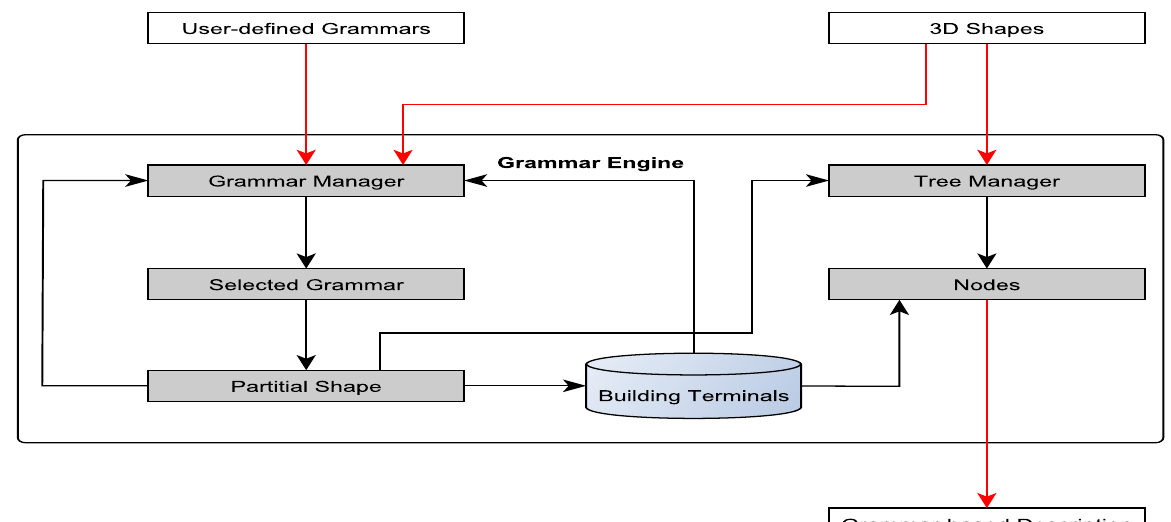
Figure 6: The main flow for proposed grammar engine is given. The block diagrams in grey indicate internal modules, and connection between internal modules uses black lines. The external module is in white block diagram and uses red lines to connect with internal modules. The blue block diagram shows a database.